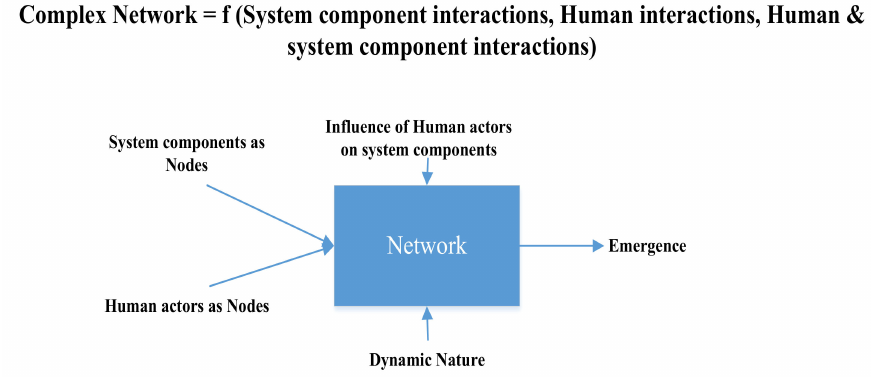
Figure 2. Abstract fundamental representation of a complex